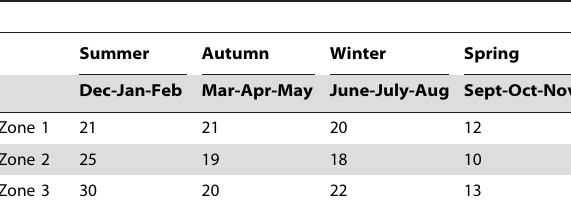
Table 3. Total number of transect replicates per seasons for each